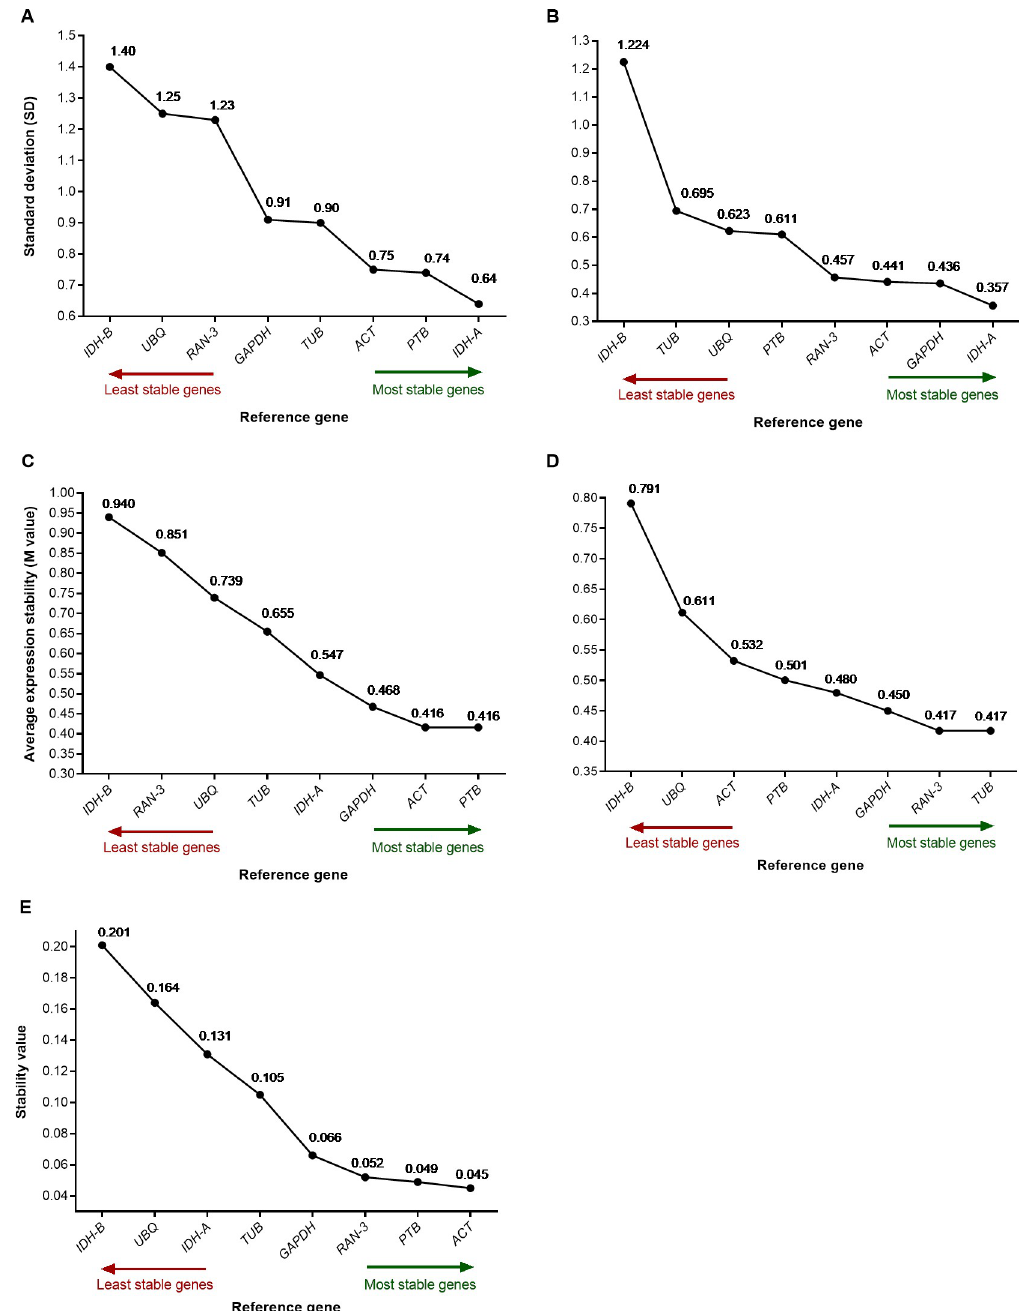
Fig 3. Expression stability ranking of the candidate genes. Rankings were calculated by (A,B) BestKeeper, (C,D) geNorm and (E) NormFinder for two C . quinoa accessions: (A,C) Titicaca and (B,D) CHEN-109. Stability values, SD and M values are shown for every gene. The most stable genes are shown on the right side (green arrow) and the least stable genes on the left (red